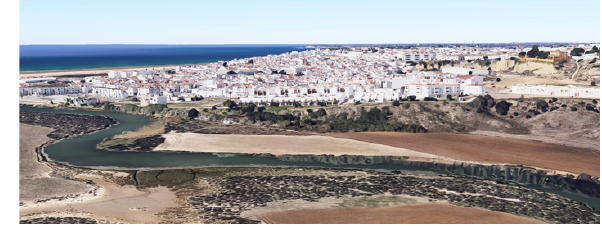
Figure 8. Current view of Conil de la Frontera (Google Earth, 2018)